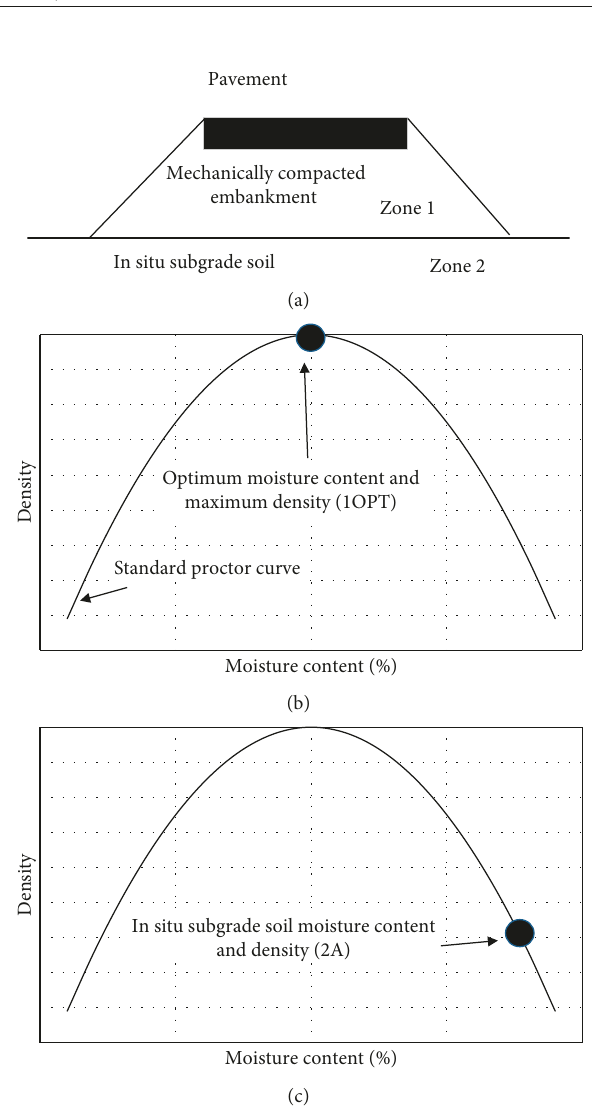
Figure 3: (a) Pavement embankment diagram, (b) moisture content-density relationship for mechanically compacted em- bankment, and (c) moisture content-density relationship for in situ